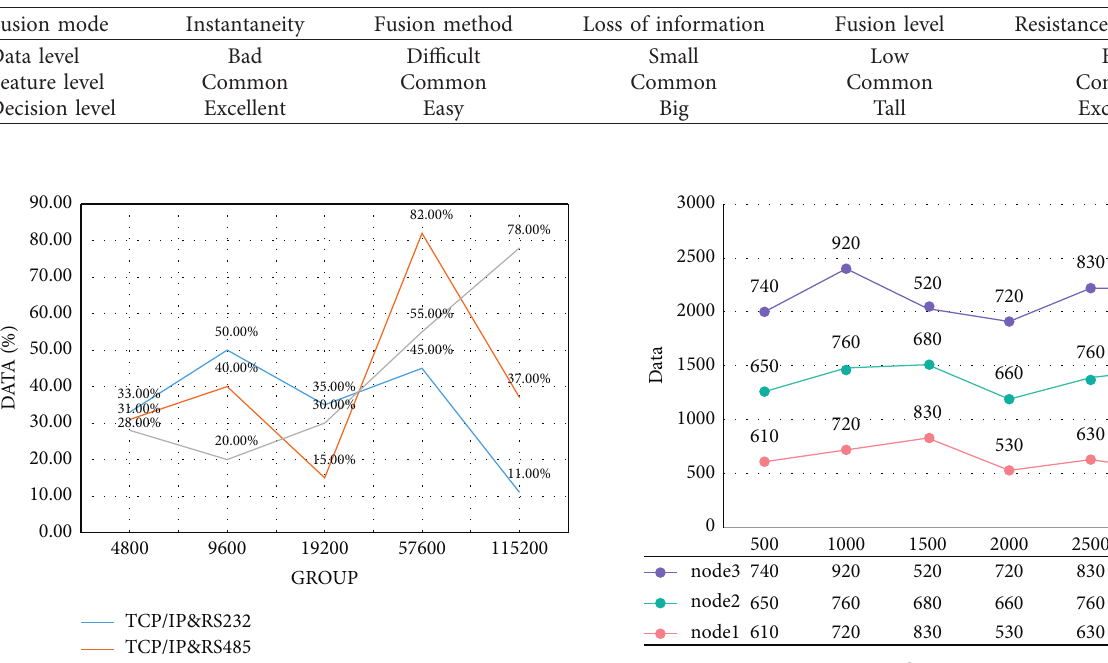
Table 1: The performance comparison of three fusion levels.